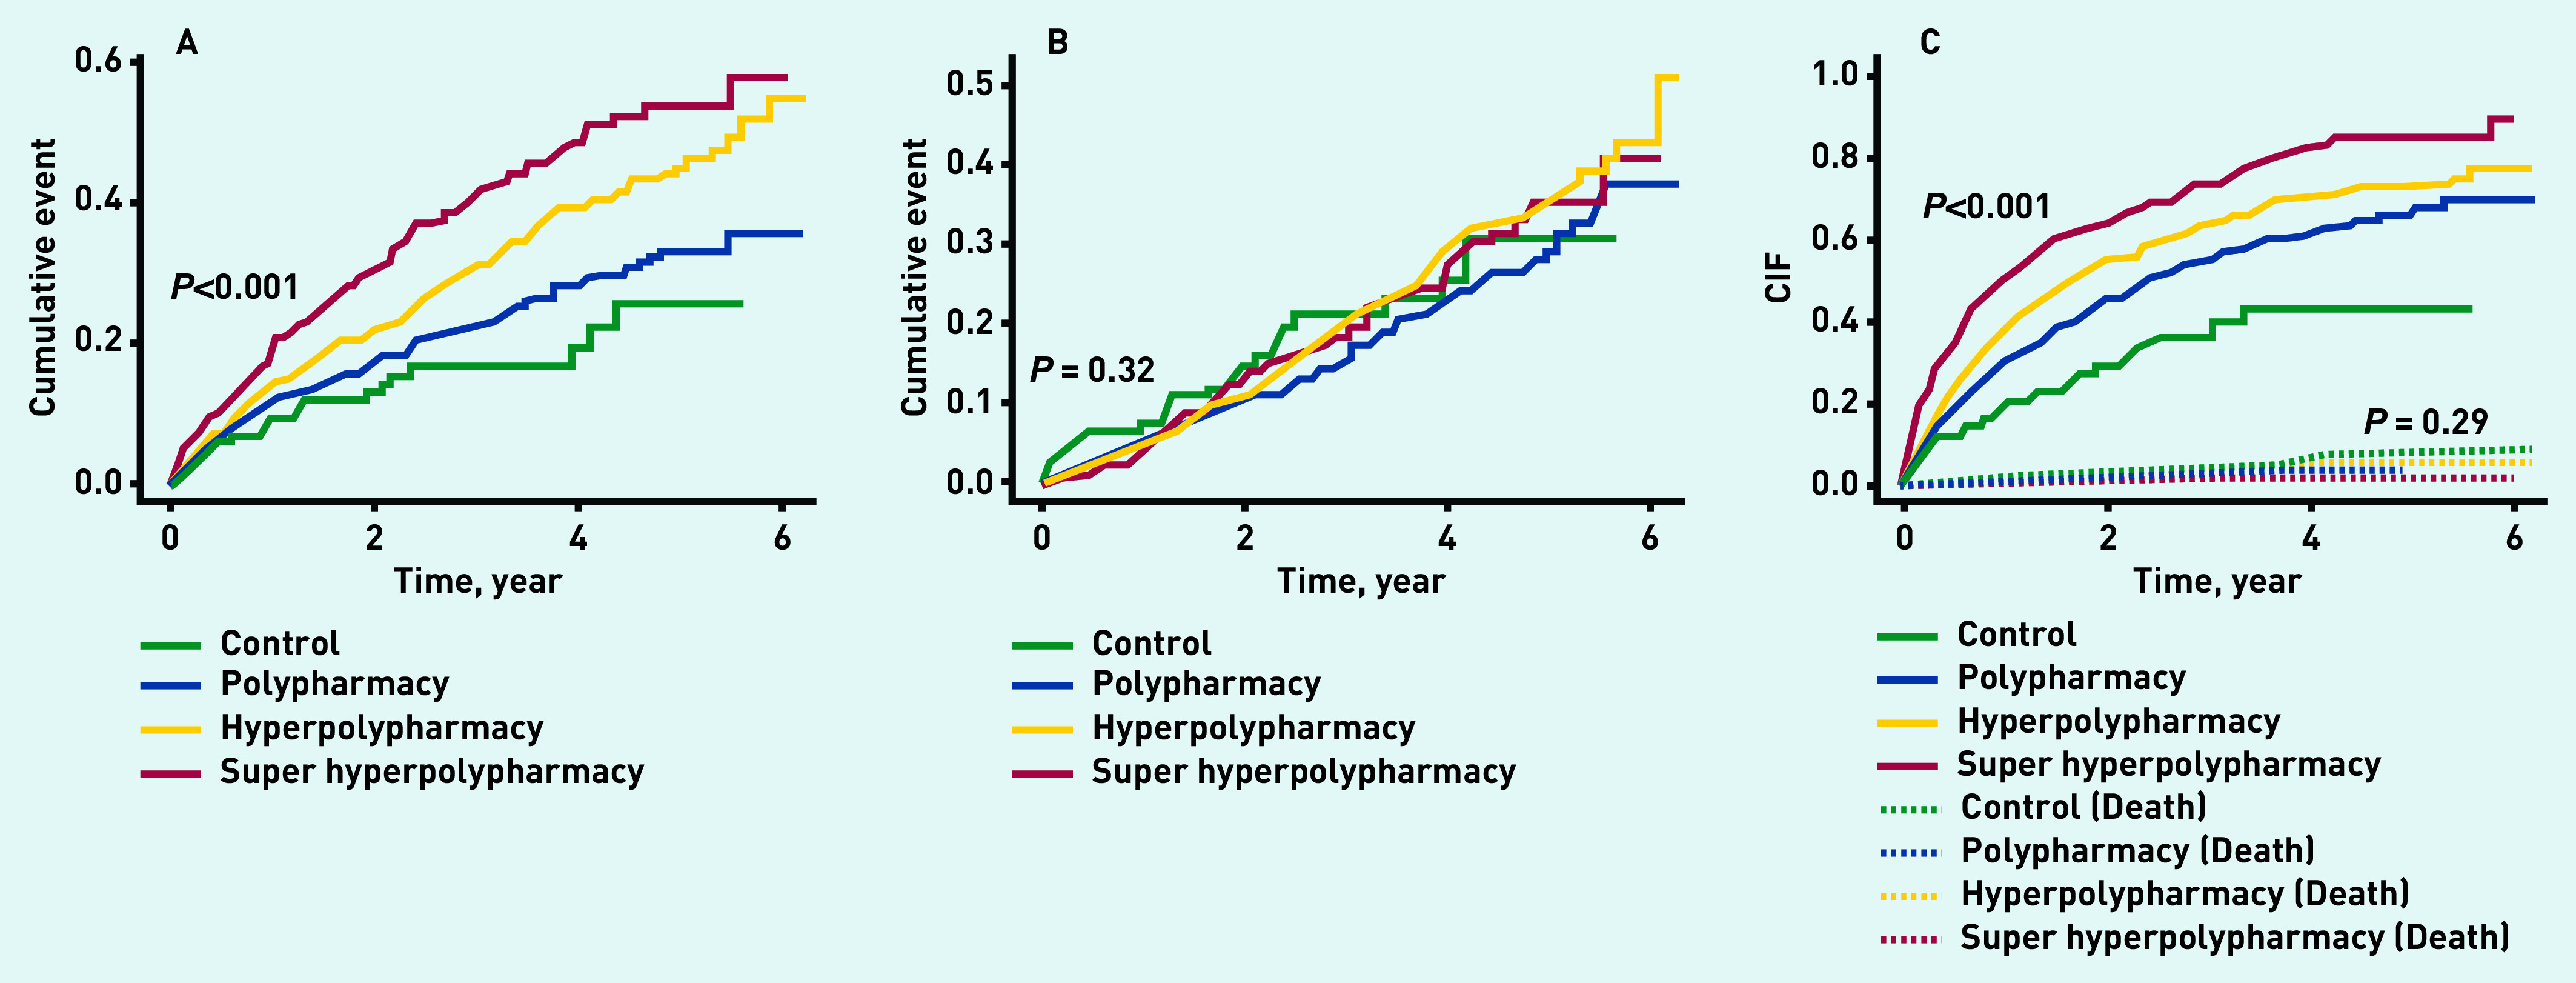
Cumulative incidence curves. A) primary composite outcome; B) all-cause death; C) all-cause hospitalisation according to total medication burden at baseline.CIF = cumulative incidence function.